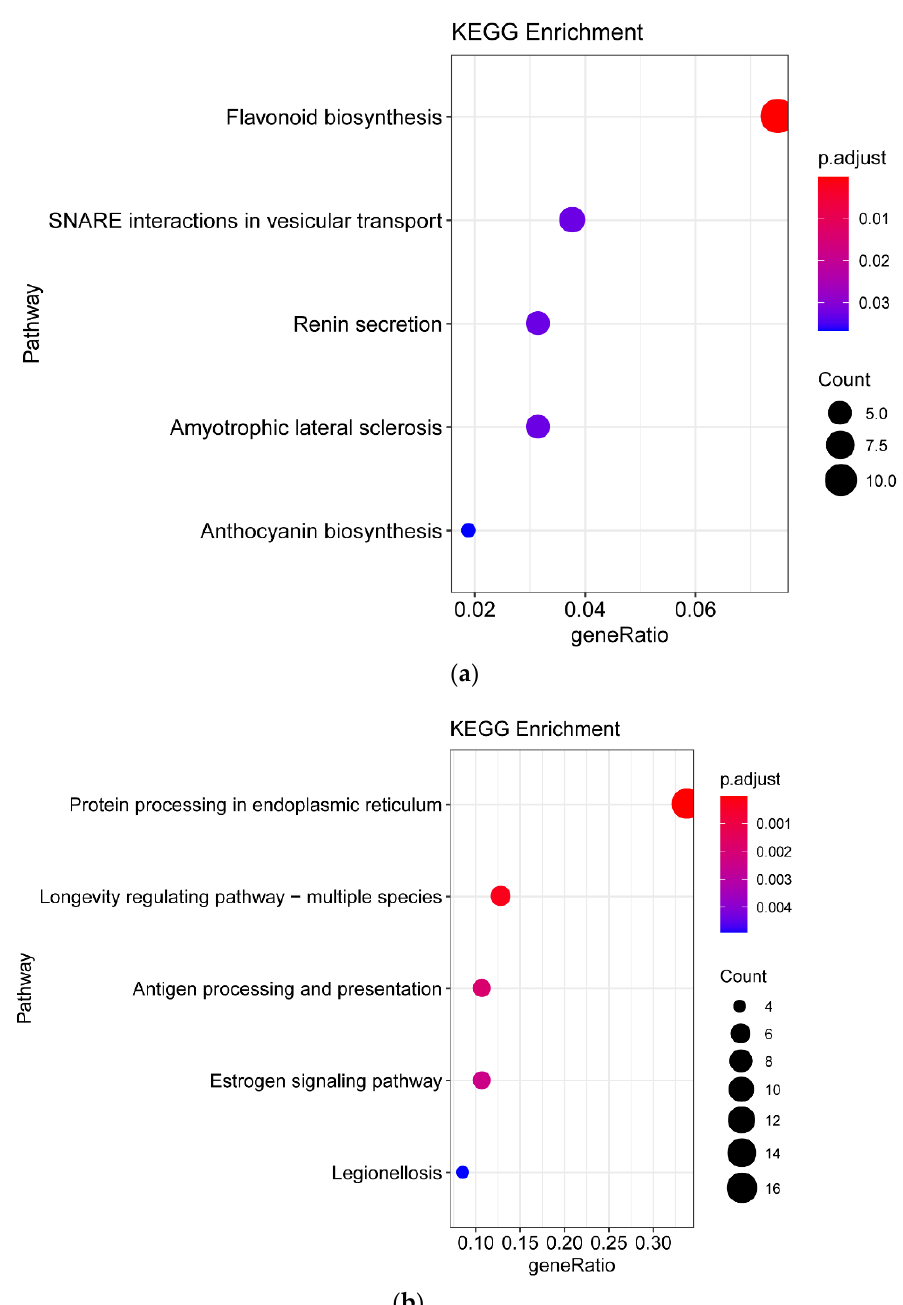
Figure 4. GO enrichment of DEGs in the root of Xiangshu99 vs. Zhezi No1. ( a ) upregulated genes; ( b ) downregulated genes. GO terms belonging to biological processes (BP), cellular components (CC), and molecular functions (MF).